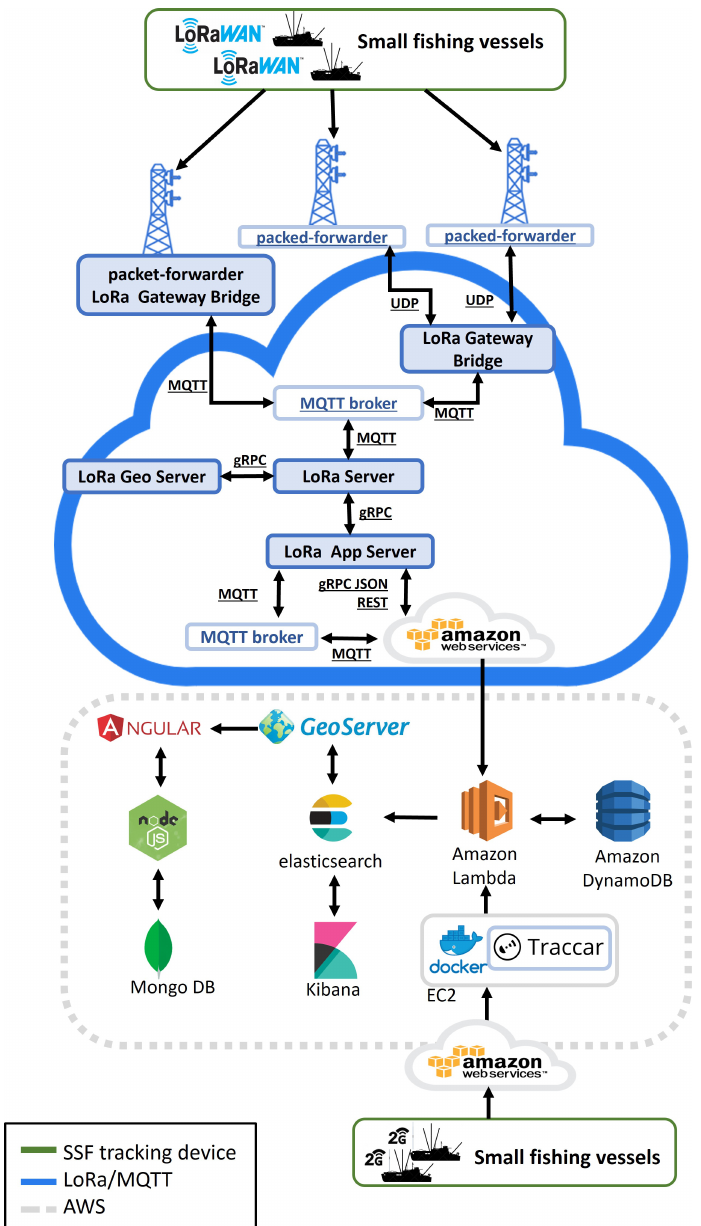
Figure 1. Architecture that manages real-time data sent over LoRaWAN and 2G/3G/4G connections. A GPS tracker collects SSF positional